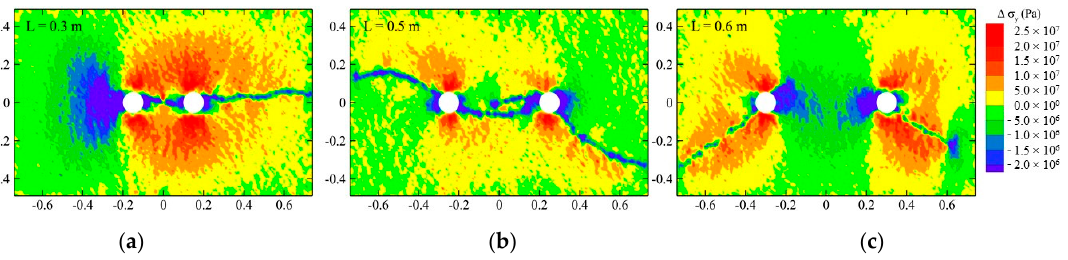
Figure 18. Vertical stress increment distributions for the two-well granite models with the different well spacing in the simultaneous fracturing when σ v = 30 MPa and σ h = 30 MPa: ( a ) L = 0.3 m; ( b ) L = 0.5 m; and ( c ) L = 0.6 m.